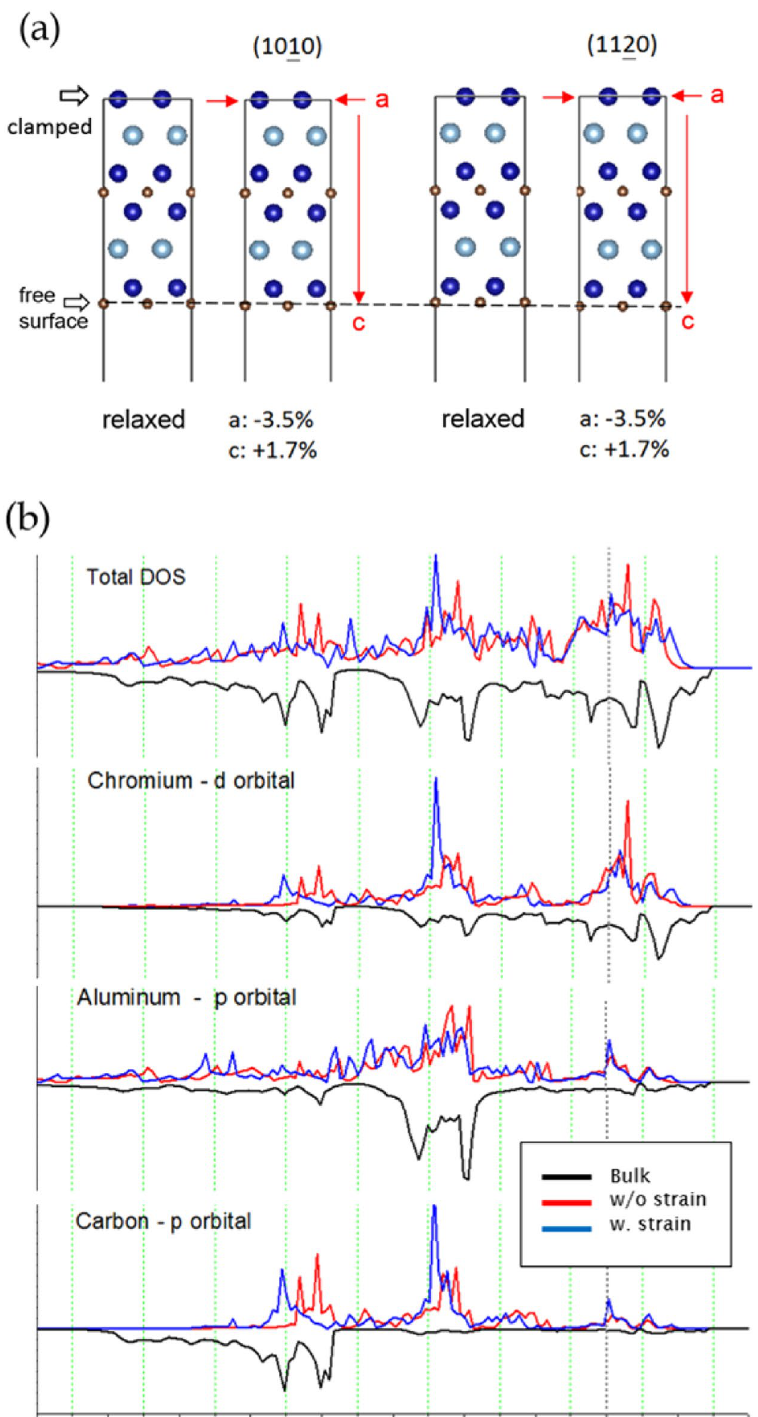
Figure 4. Density functional theory investigations. Structured model for Cr 2 AlC with periodic boundary conditions in the lateral directions with applied strain ( a ). Calculated density of states (DOS in arb. units) for Cr 2 AlC ( b ): total, partial chromium d states, aluminium p states, and carbon p states. The Fermi level is set to 0 eV. The comparison of the DOS data is focused on the atoms from the bulk, atoms close to the surface without strain, and atoms close to the surface with strain